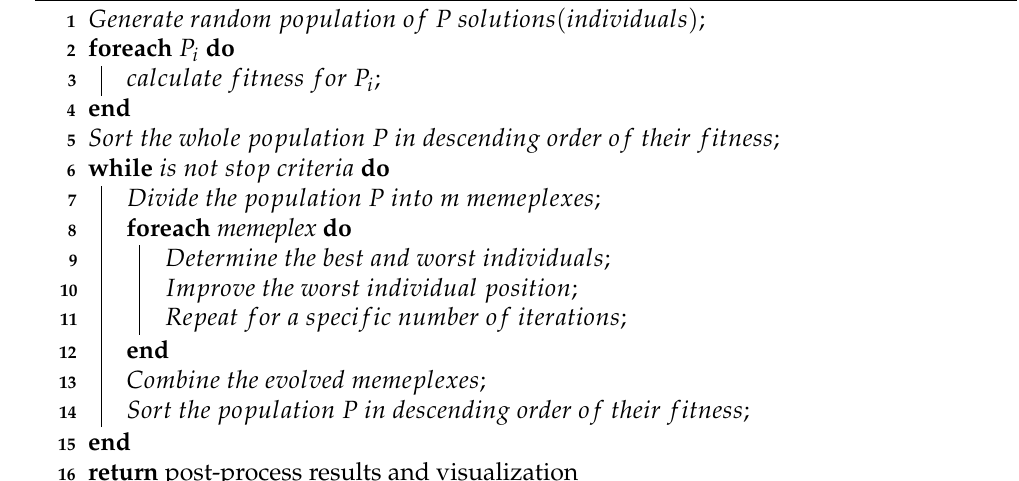
Algorithm 3: Shuffled frog leaping